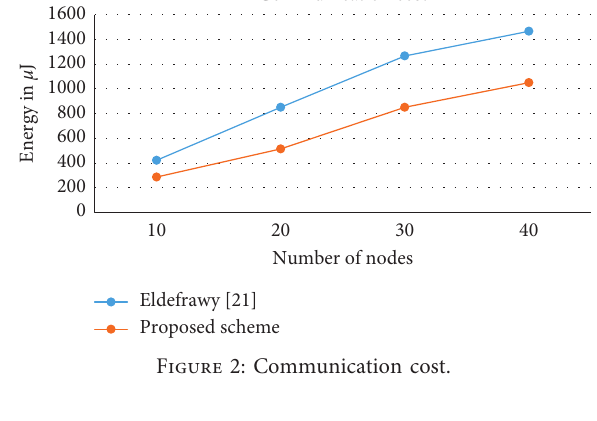
Table 3: Simulation parameter for the proposed scheme.